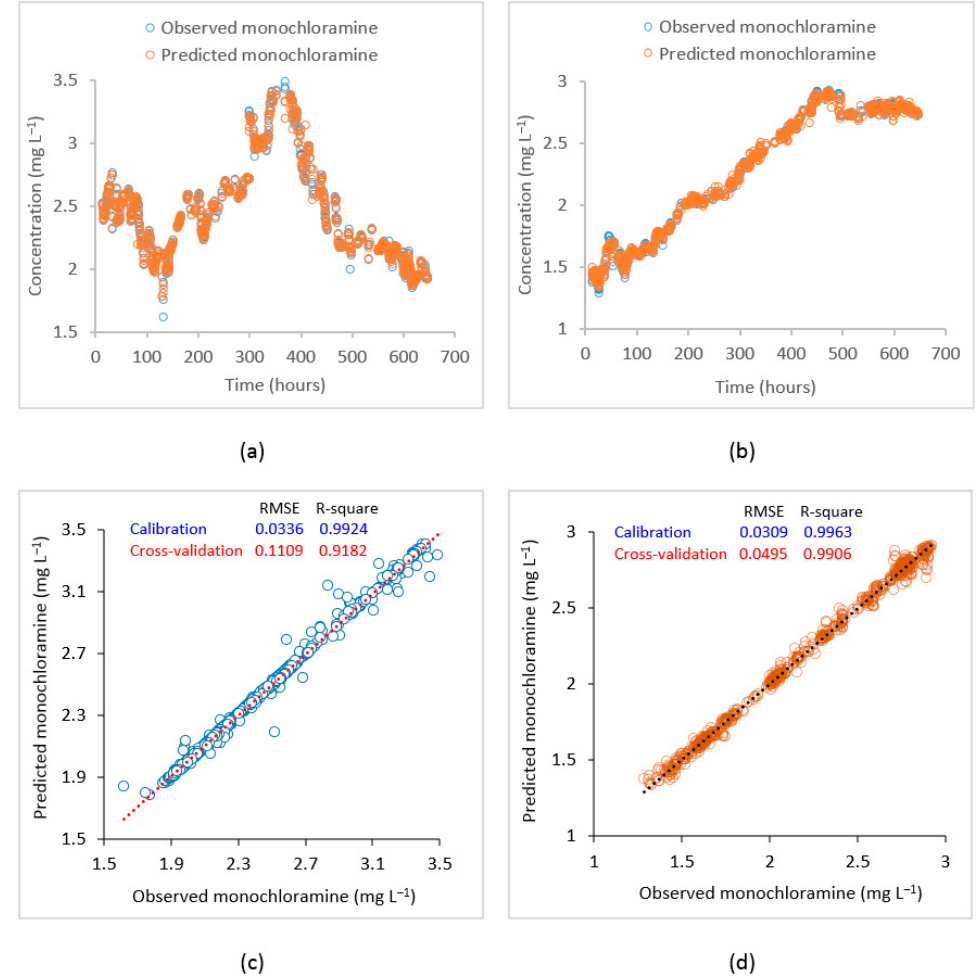
Figure 7. Plot of observed vs. SVR predicted monochloramine concentrations. ( a ) Time ‒ series at PS2, ( b ) time ‒ series at Meningie, ( c ) correlation plot at the PS2 inlet, and ( d ) correlation plot at Meningie.